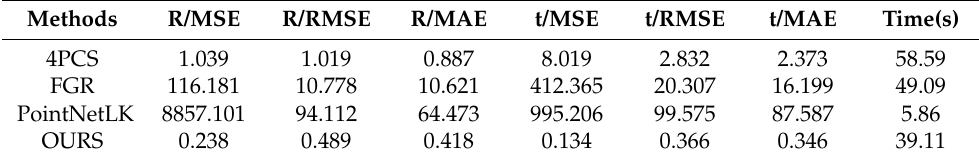
Table 6. Registration error and time of different methods for campus scenes.